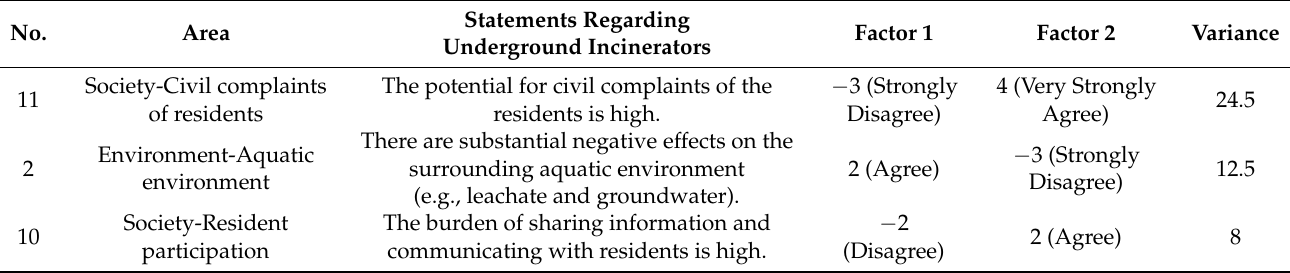
Table 8. Distinguishing statements on underground